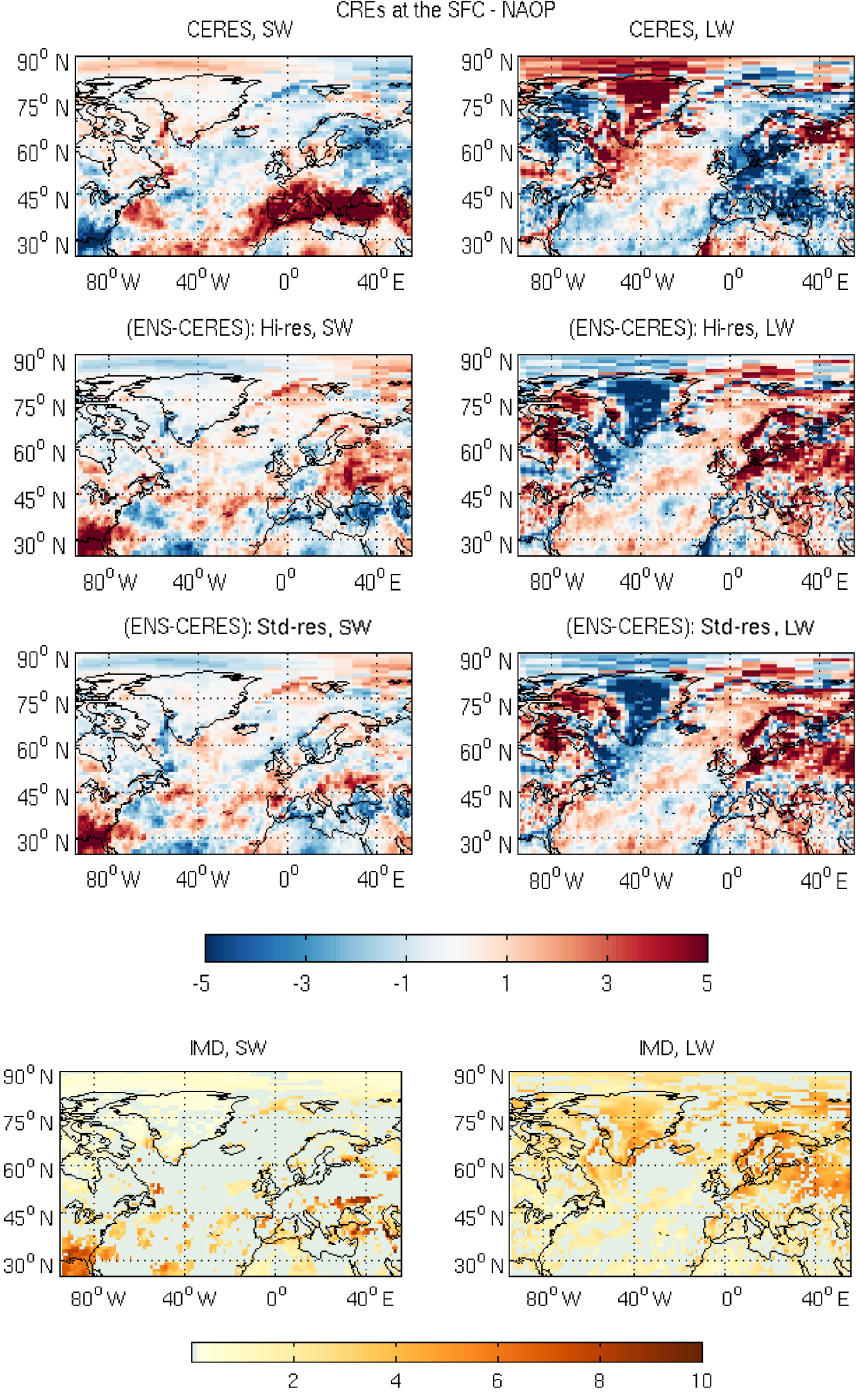
Figure 12. Same as above but for the cloud radiative response at the